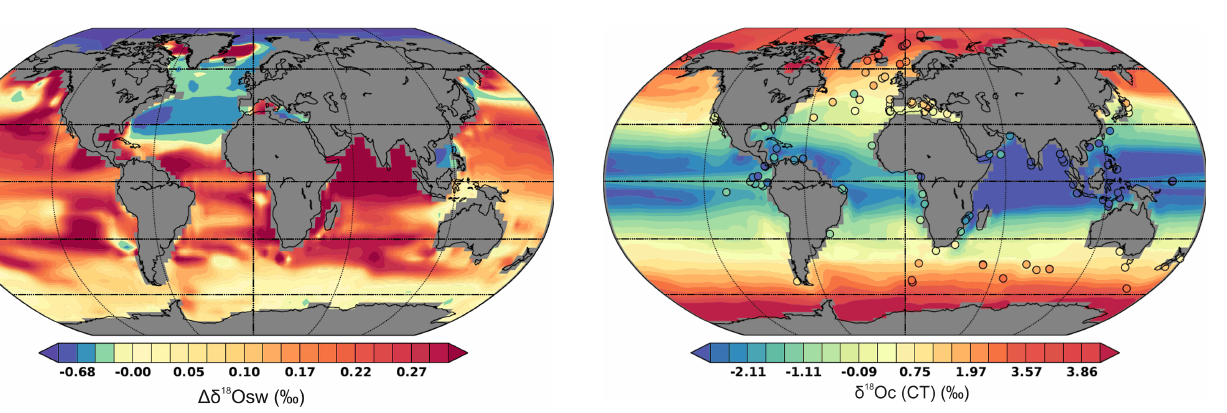
Figure 6. Simulated surface water δ 18 O anomaly (LGM-CT) in i LOVECLIM. A correction of the LGM ice sheet contribution (1‰) has been applied. For colour scale generation explanations see Fig. 1 caption.